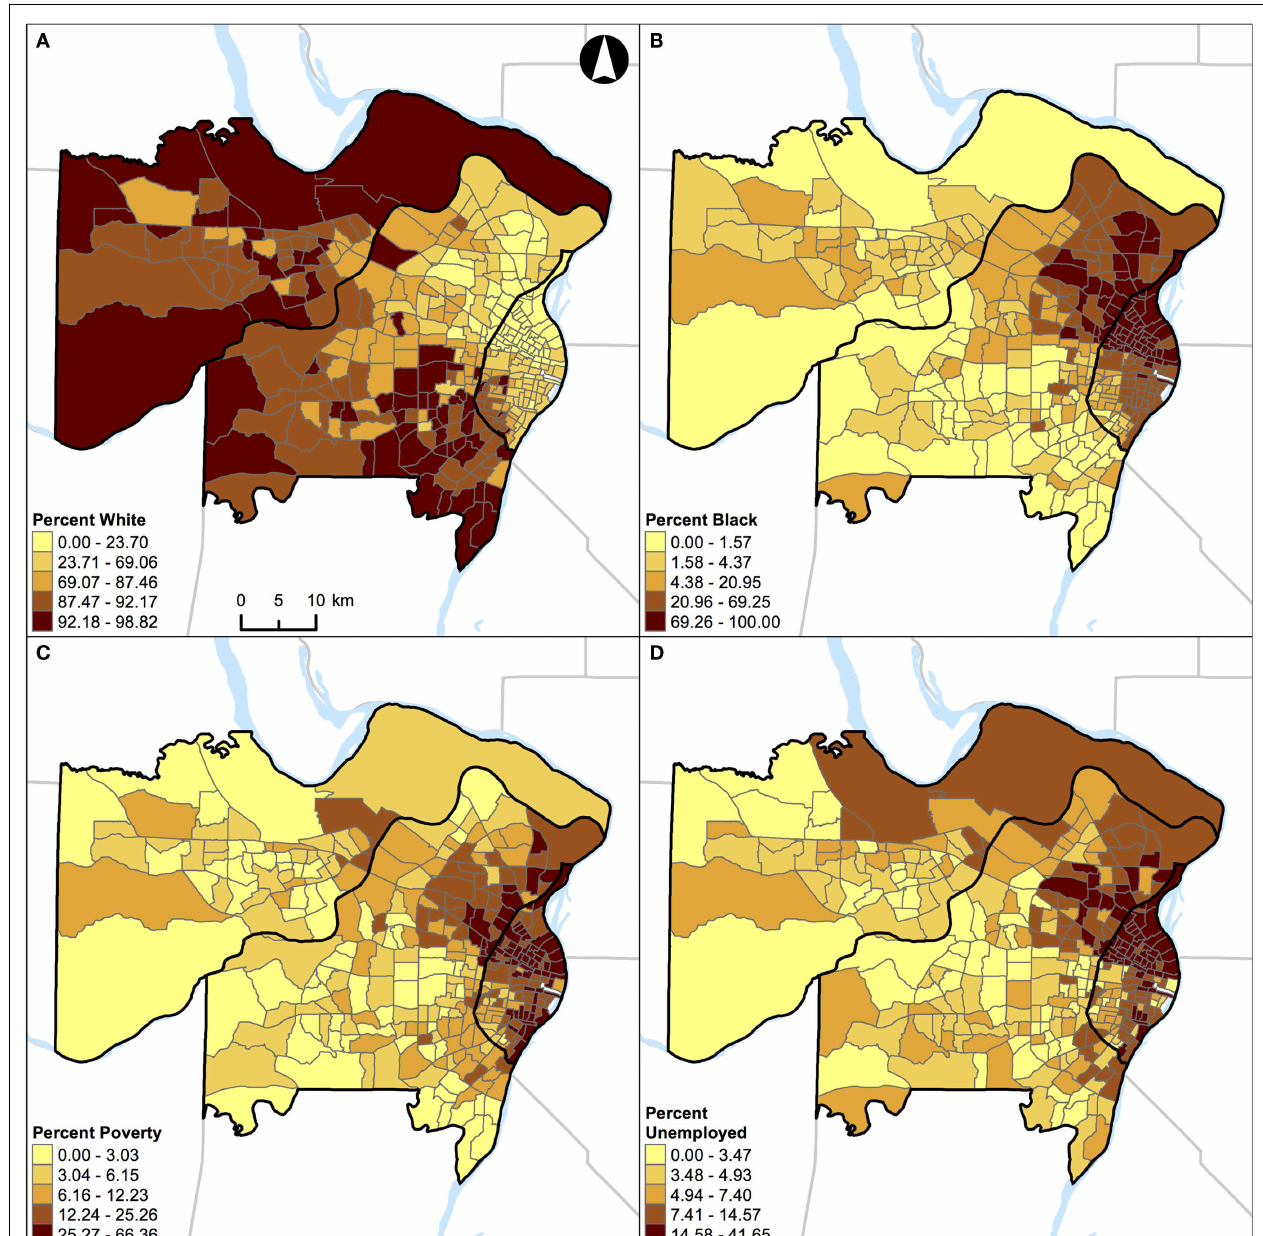
FIGURE 8 | Geographic distribution of population characteristics expressed as percentages in St. Louis, MO, USA (340 census tracts) . (A) Percent white, (B) percent black, (C) percent Hispanic, and (D) percent other racial/ethnic groups. A quantile classification scheme was used to display the percentages.